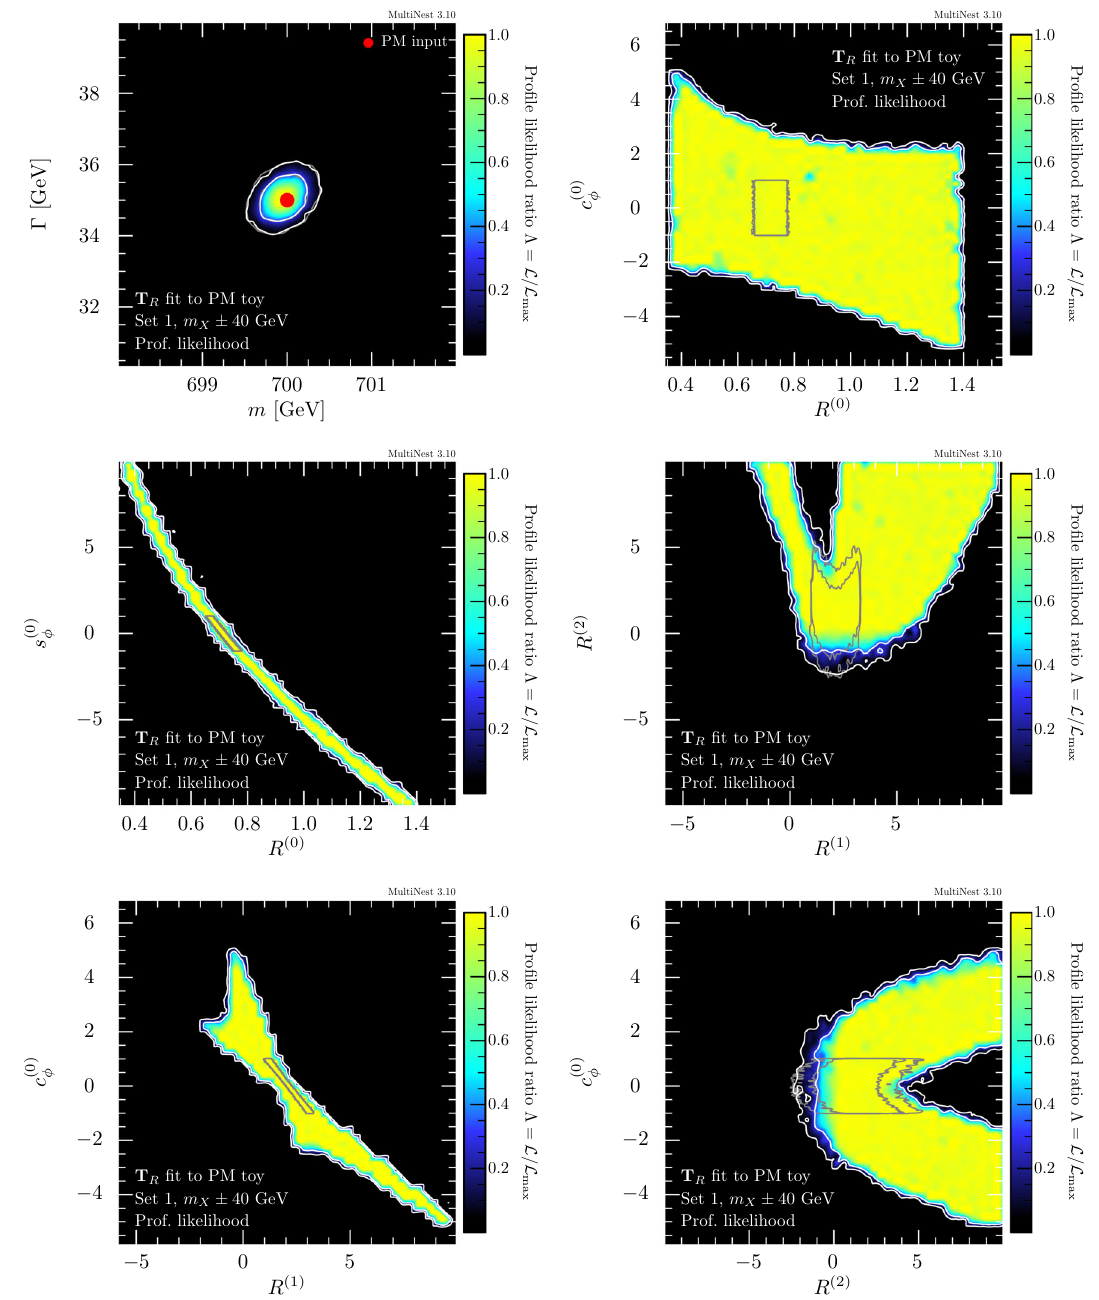
Fig. 8 Fit result of the T R parameters to a PM Asimov toy over the m X ± 40GeV window. The toy corresponds to the m X = 700GeV, (cid:3) / m = 5%, and set 1 input parameters. Two-dimensional profile X X likelihood plots are presented, with 1 σ and 2 σ boundaries outlined in